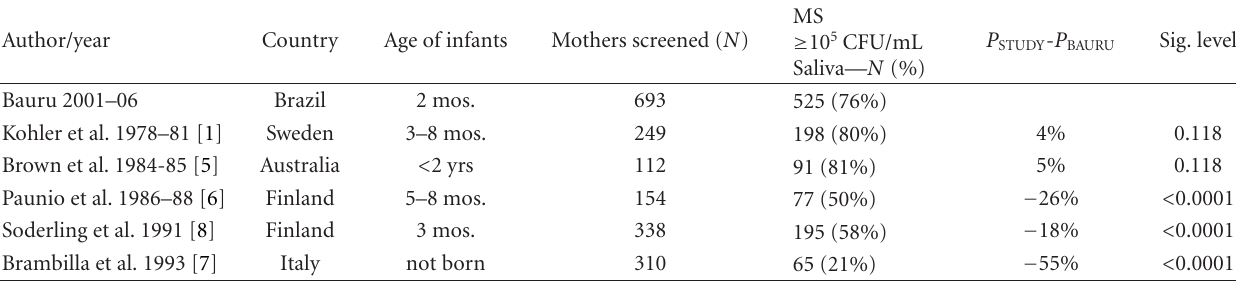
Table 3: Studies on the prevalence rates of salivary levels of the mutans streptococci in